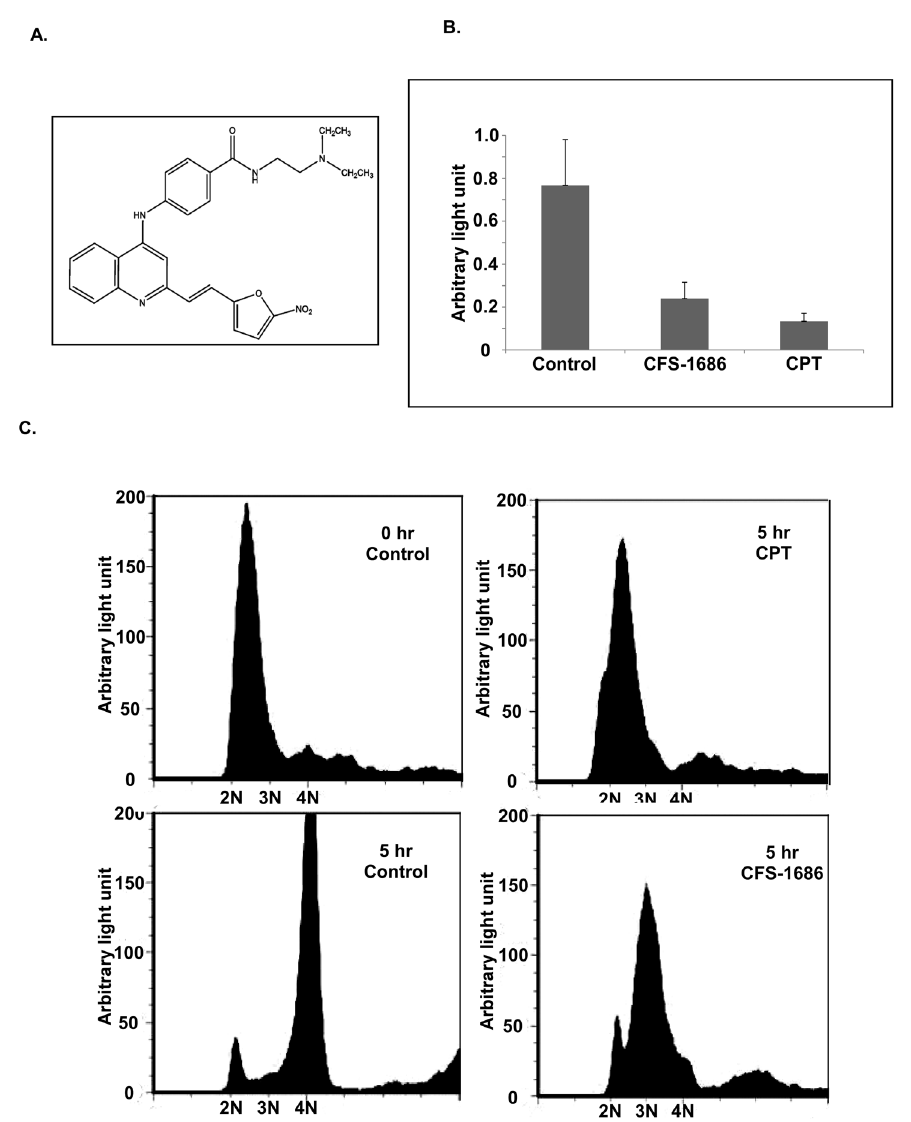
Figure 1. CFS-1686 and CPT induced cell cycle arrest at the G1/S boundary and intra-S in PC3 cells, respectively. (A) The chemical structure of CFS-1686. (B) BrdU incorporation of synchronized PC3 cells treated by CFS-1686 or CPT for over 5 hrs. (C) Flow cytometric analyses of synchronized PC3 cells treated by CFS-1686 or CPT for over 5 hrs. Analyses were in triplicate and representative histograms are shown. The X and Y axes represent DNA content and cell numbers,